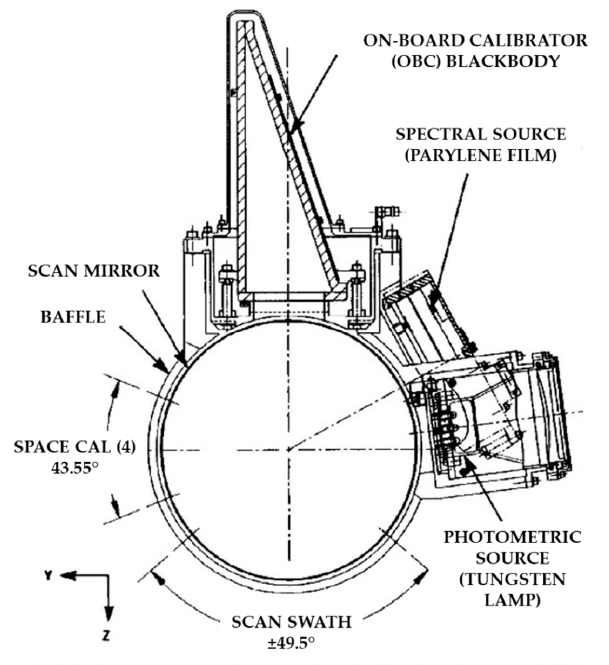
Figure 3. The AIRS scan cavity and calibration targets. Radiometric calibration is performed using views of the on-board calibrator (OBC) blackbody and space obtained on every